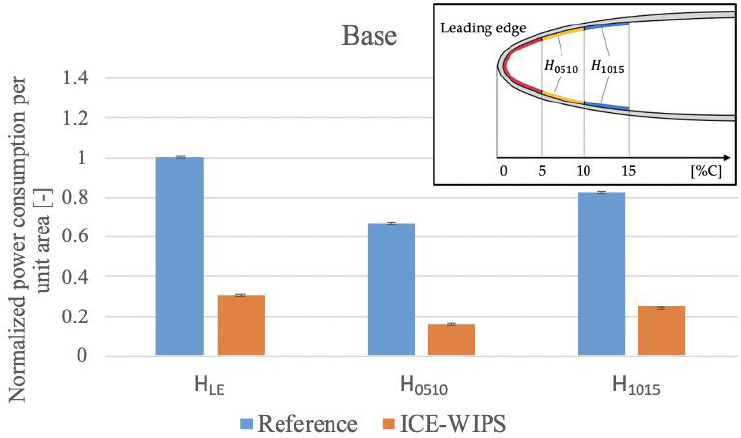
Figure 11. Normalized power consumption per unit area of each heating area for Base case. Aerospace 2020 , 7 , x FOR PEER REVIEW